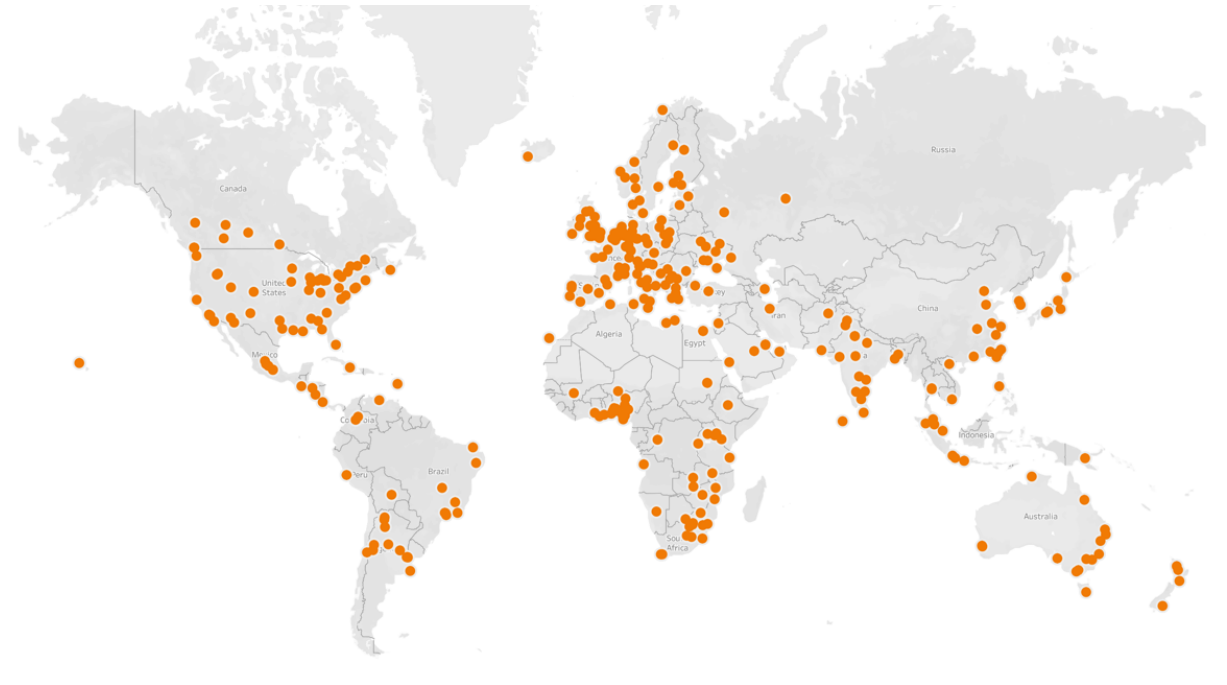
Figure 3. Distribution of 564 self-registered educational planning institutions. Source: Authors, based on the ISOCARP